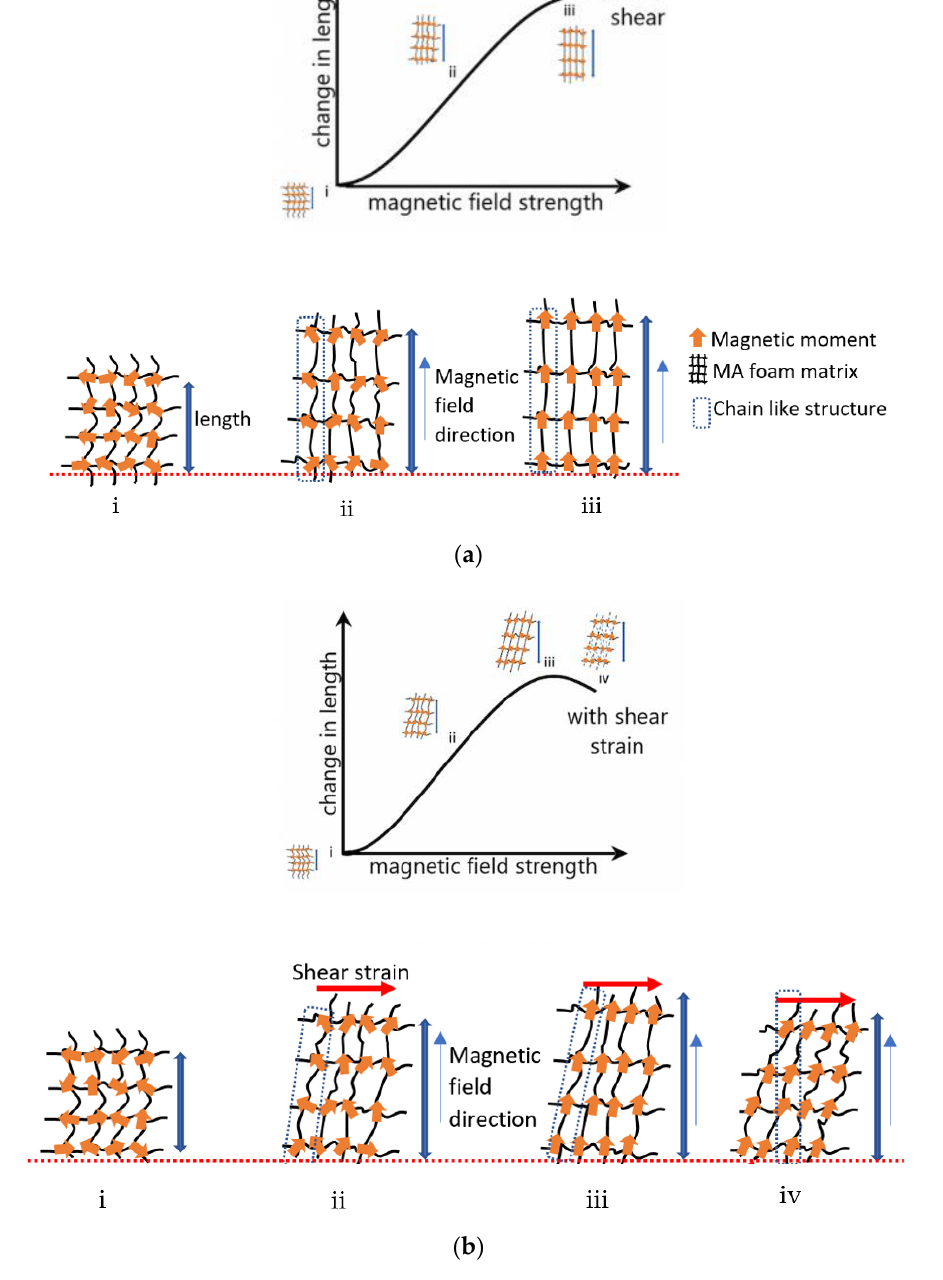
Figure 11. Change in length of MA foam under ( a ) zero and ( b ) 0.001% shear strain with schematic physical property diagram transition.